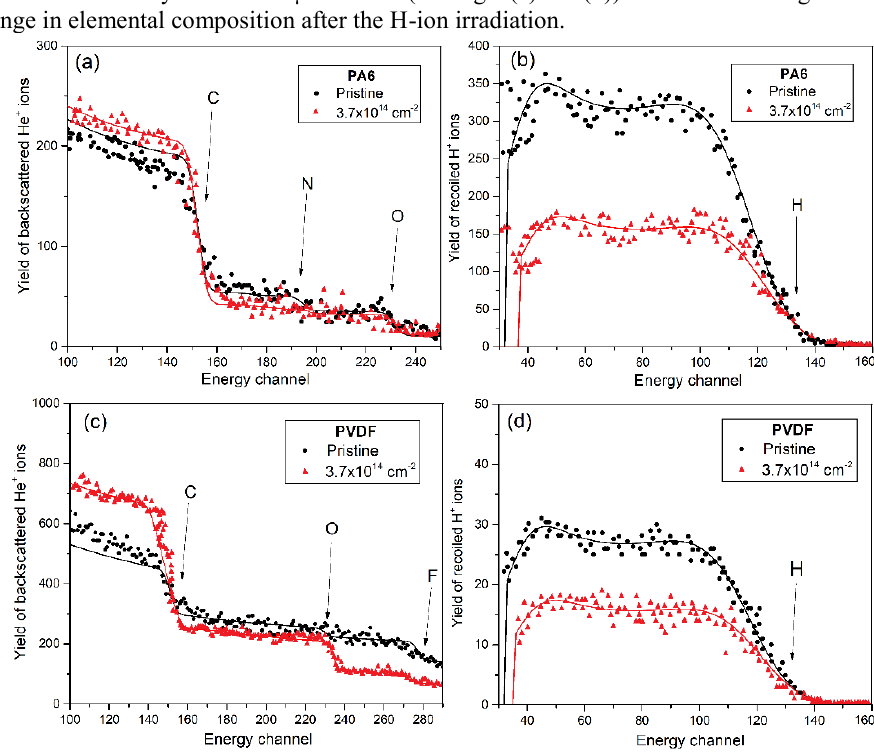
Fig. 2. RBS experimental (points) and SIMNRA simulated (line) spectra for PA6 (a) and PVDF (c) are presented together with ERDA experimental (SIMNRA simulated (line) spectra for PA6 (b) and PVDF